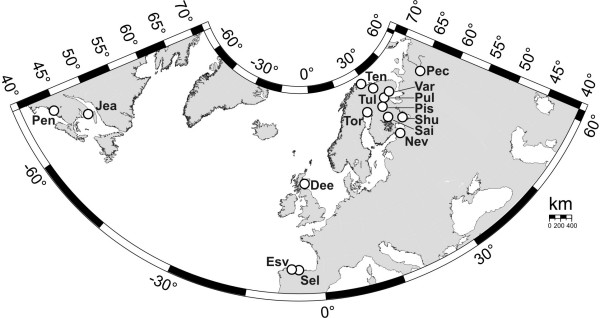
Locations of the 15 Atlantic salmon population analyzed in this study. One individual was sampled from each population and their abbreviations were: Penobscot, USA (Pen), St Jean, Canada (Jea); Dee River, UK (Dee); Esva River, Spain (Esv); Sella River, Spain (Sel), Tenojoki River, Finland (Ten); Tuloma River, Russia (Tul); Tornionjoki River, Finland (Tor); Pechora River, Russia (Pec); Varzuga River, Russia (Var); Pulonga River, Russia (Pul); Pistojoki River, Russia (Pis), Shuja River, Russia (Shu); Lake Saimaa, Finland (Sai) and Neva River, Russia (Nev).